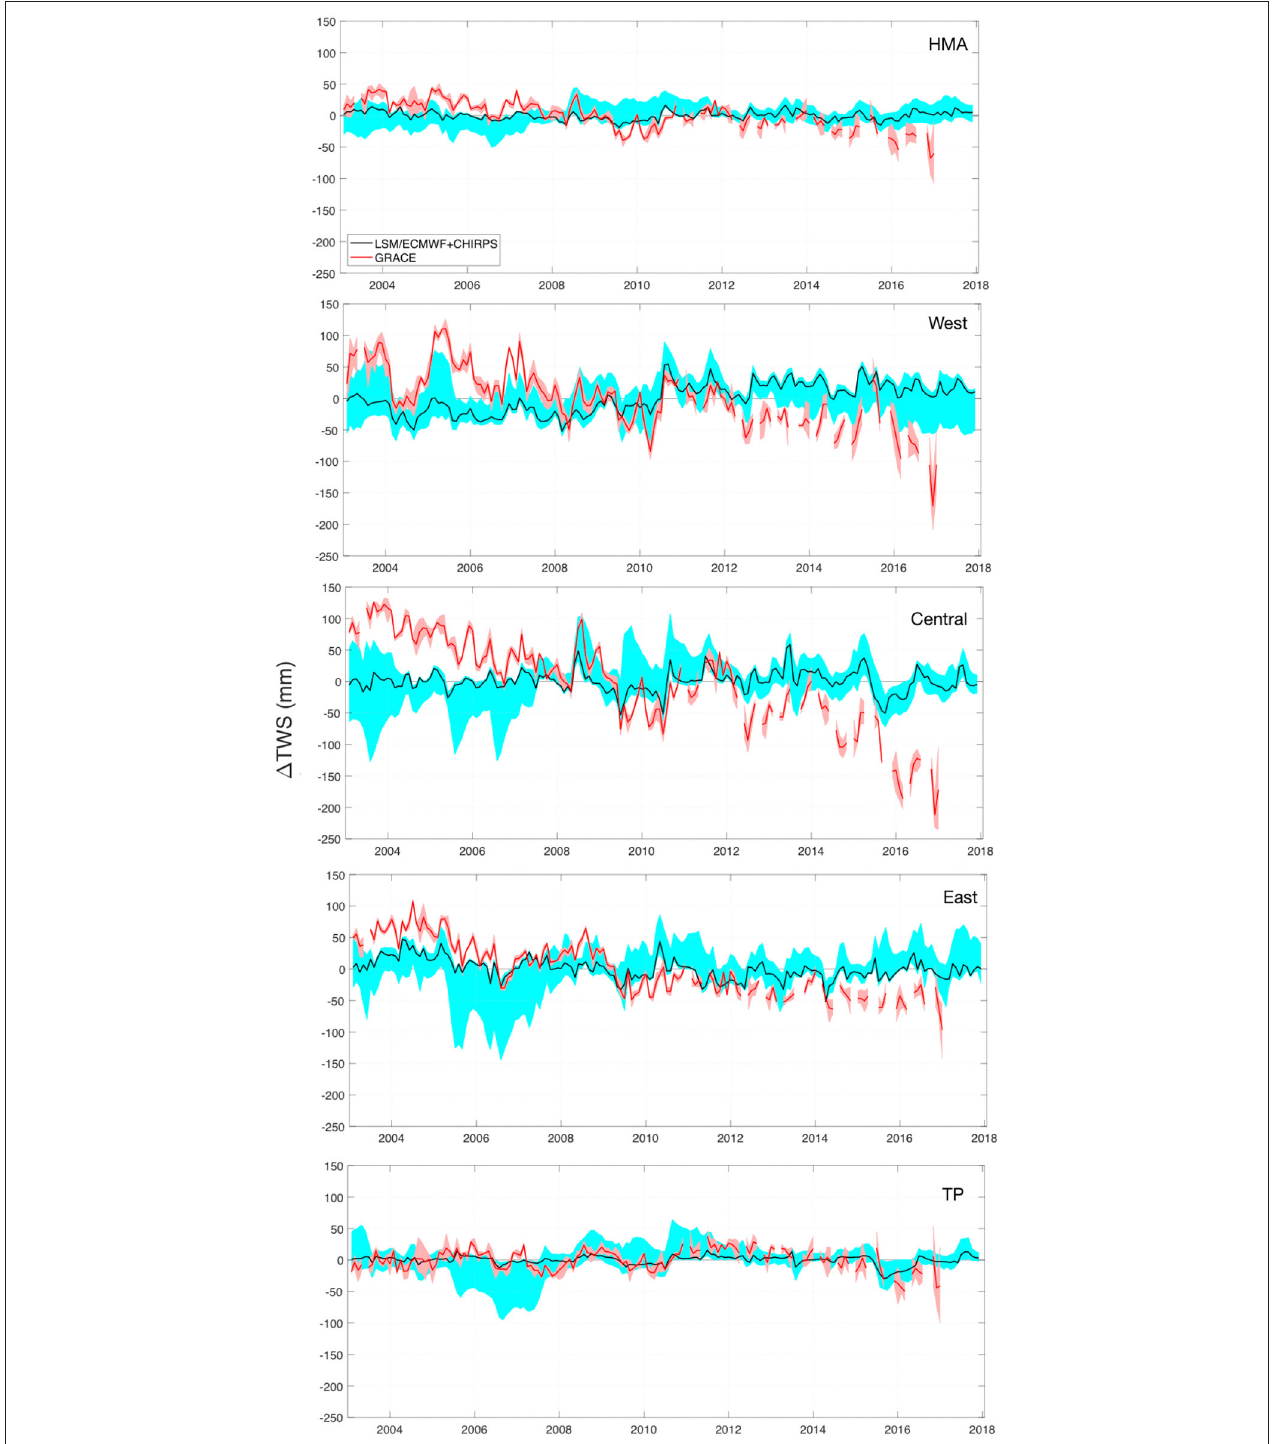
FIGURE 13 | The time series of the anomalies in TWS (mm) from GRACE and the model runs during 2003–2018. The red and cyan shadings represent the spread in TWS anomalies across the GRACE products and LSMs, respectively. The average TWS anomaly estimates from models driven by the ECMWF +CHIRPS forcing are shown in